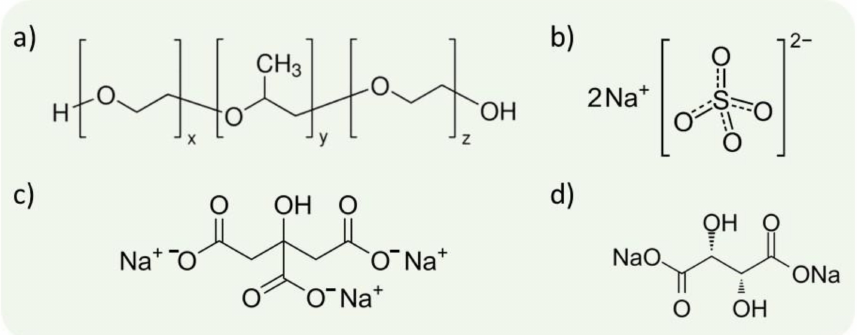
Figure 1. Molecular structures—( a ) Pluronic L64; ( b ) Sodium sulfate; ( c ) Sodium citrate; ( d ) Sod‑ ium